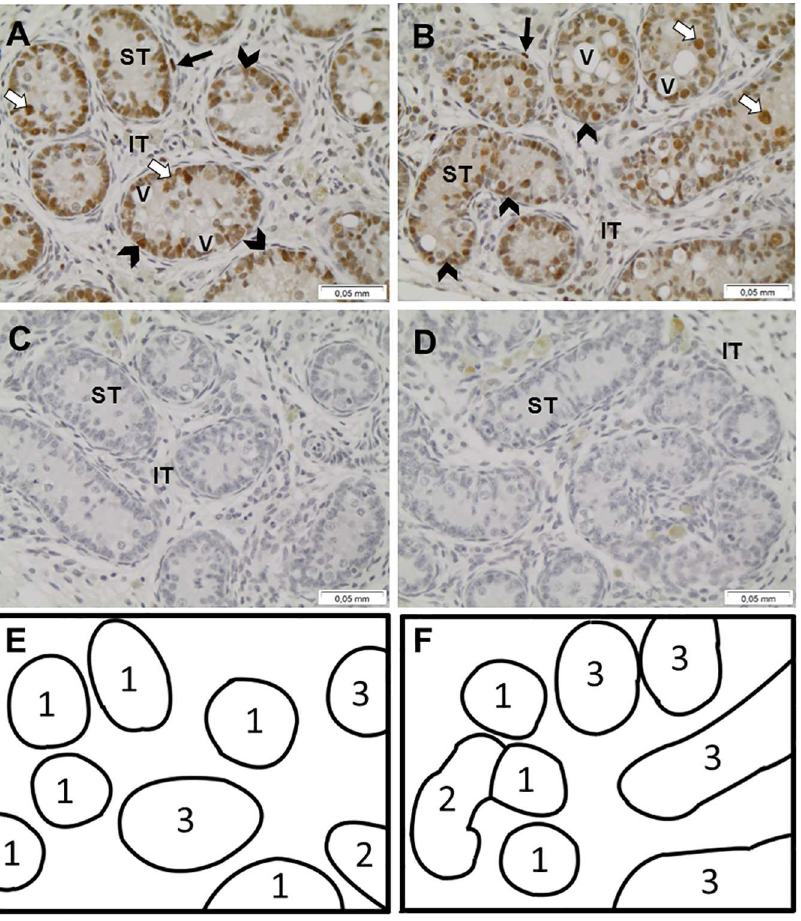
Fig 5. Immunohistochemical detection of PCNA protein in equine prepubertal testes. Representative testicular sections for foals born to forage fed (A, n = 6), or barleyand forage fed dams (B, n = 7), with respectivenegativecontrols (C and D). Lumen scores are represented within each tubule for F foals in testicular section (E) and B foals in testicular section (F). Arrow heads indicateSertoli cells, white arrows, gonocytesand black arrows, peritubularcells. ST: seminiferous tubule, IT: interstitial tissue, V: vacuoles. All cellulartypes constitutingthe seminiferous epithelium, Sertoli cells and gonocytesare positive for PCNA staining.Scale bar = 0.05